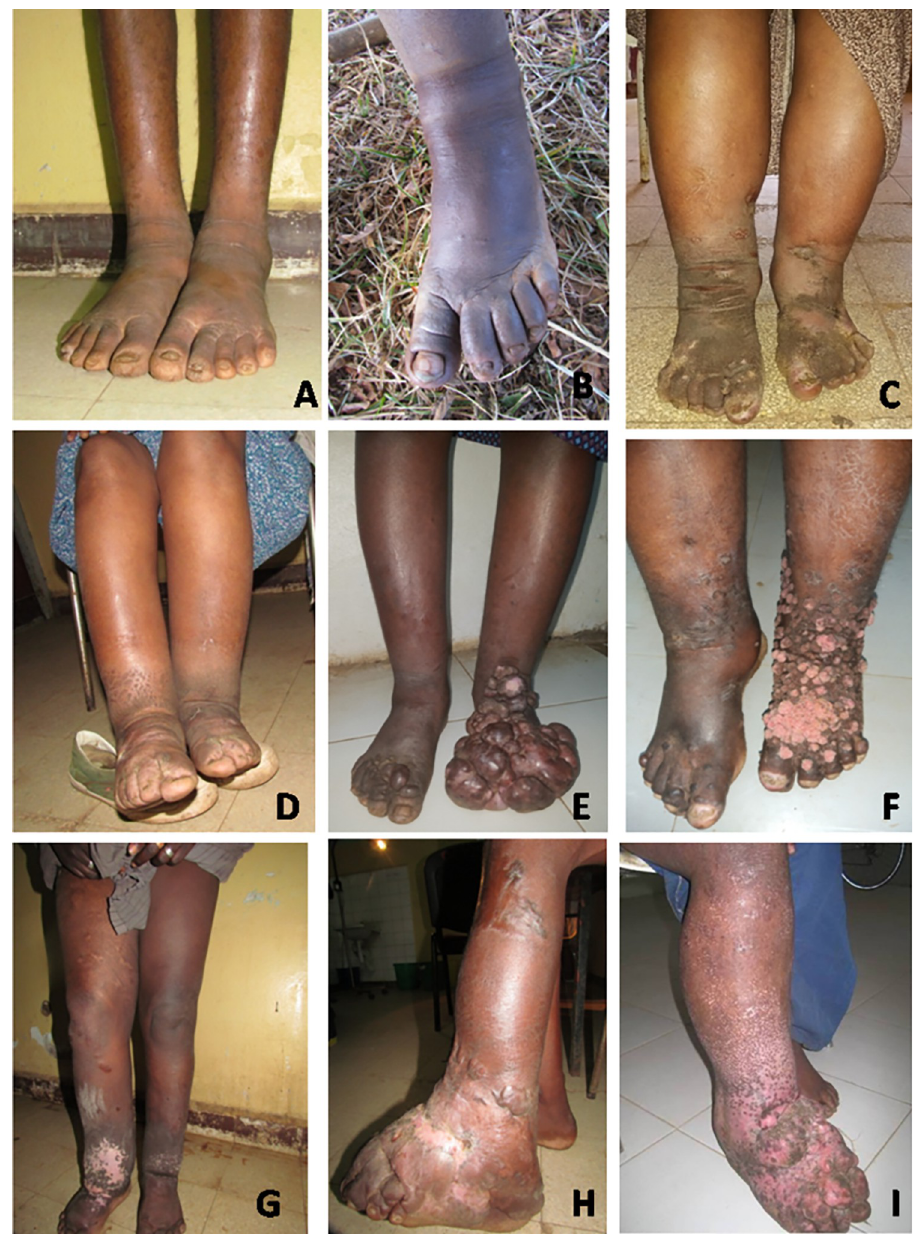
Fig 1. Most common characteristics of the various stages of podoconiosisin, in Durbete Podoconiosis Prevention and Treatment Centre, Durbete, Ethiopia, February 2018 to October 2019. A) Stage 1: overnight reversible oedema, with increased skin marking and hyperkeratosis on the base of the toes of both the right and left foot. B) Stage 1: splaying of the right forefoot, accentuation of the skin markings on the metatarsophalangeal joint. C) Stage 2: bilateral lymphoedema below the knee. Area of scarring is seen on the lower leg and foot (from traditional bloodletting). Hyperpigmented, warty hyperkeratotic papules covering the dorsum of the feet extending to the ankle. Nodules on the right forefoot. D) Stage 2: Pitting lymphoedema below the knee, with dry skin. E) Stage 2(right foot) and stage 3 (left foot). Right foot: pitting lymphoedema on the shin, few papules and nodules on the dorsum anterior one third of the foot and toes. Left foot: smooth surface with multiple nodules and tumorous masses covering the whole foot and flexural ankle with extension to the anterior distal one third of the lower leg. The foot is totally deformed and the toes are no longer visible. Based on the extension of the nodules the right foot is stage 2 (nodules below the ankle only) and the left foot stage 3 (nodules extending above the ankle). F) Stage 3: Bilateral lymphoedema. On the right leg the swelling is pitting on the proximal half of the lower leg and non-pitting fibrotic edema on the distal one third of the lower leg and foot. Scattered, infiltrative papules on the dorsal distal one third of the foot and toes. Hyperkeratotic